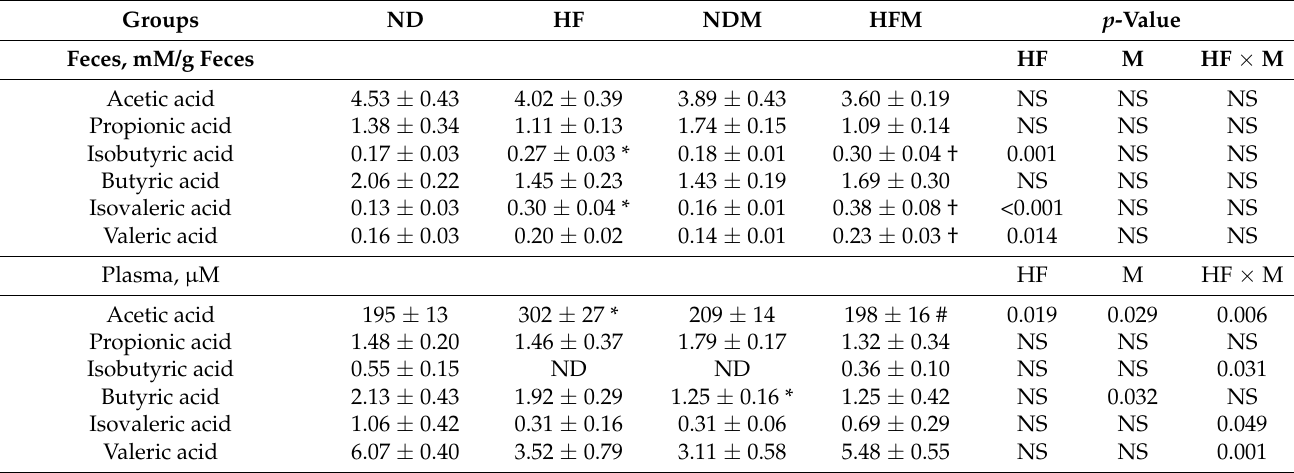
Table 2. Plasma and fecal short chain fatty acid (SCFA) levels.